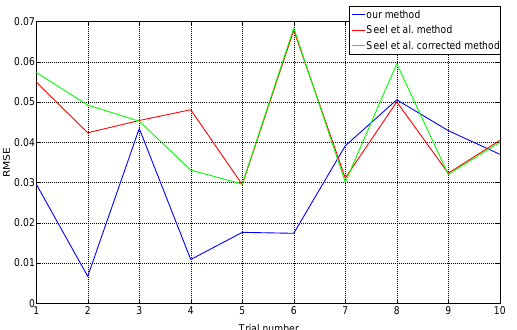
Figure 8: Results on real measurements: RMSE for one IMU to body configuration and 10 trials performed by one subject.